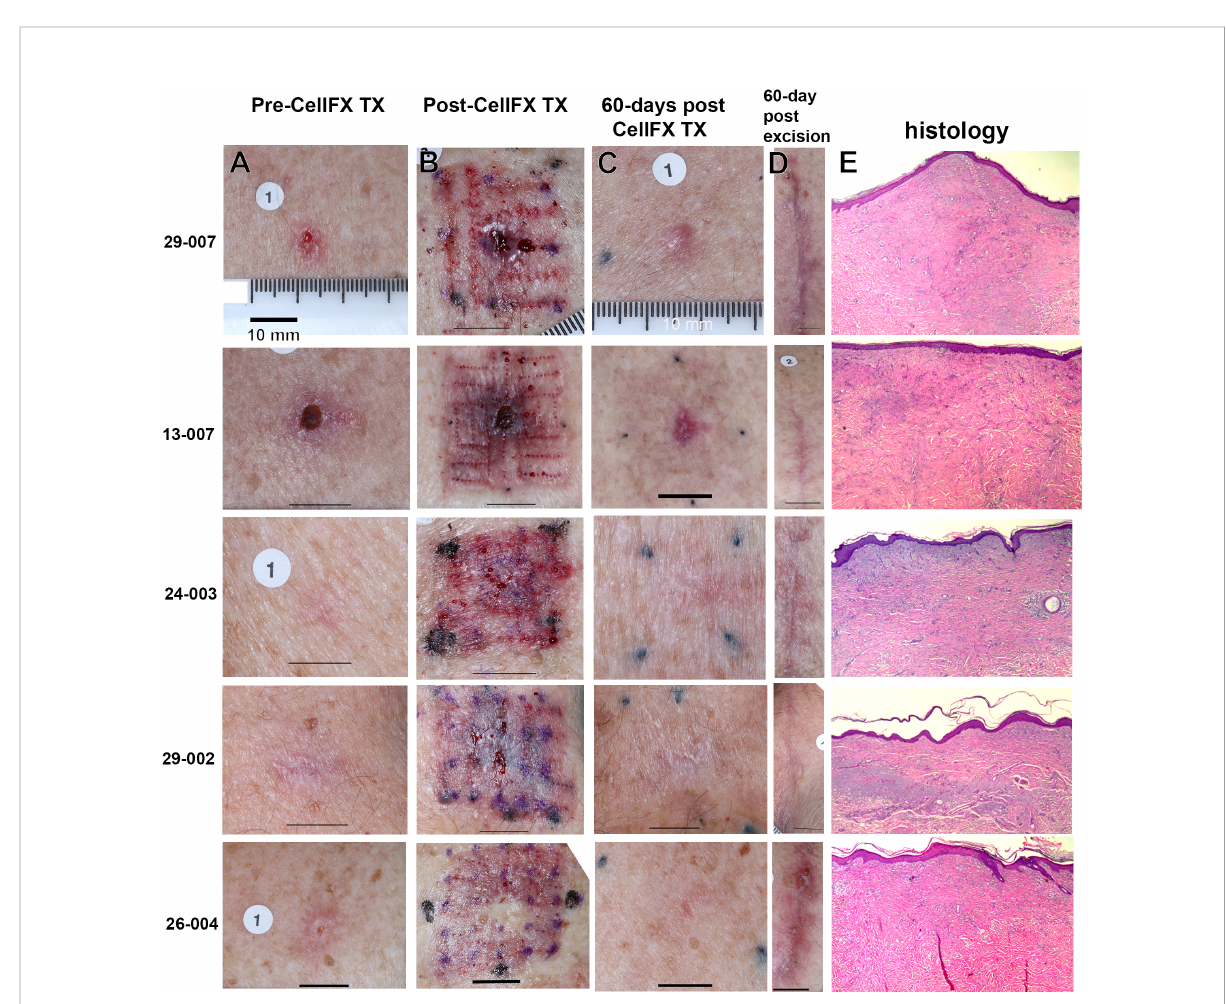
FIGURE 2 Five BCC lesions treated with the CellFX System and excised after 60 days for histological examination. 29-007 was treated with four placements of the 10 x 10 mm tip; 13-007 was treated with nine placements of the 7.5 x 7.5 mm tip; the remaining three were treated with 9, 12, and 16 placements, respectively, of the 5 x 5 mm tip. (A) Photos of lesions before treatment. (B) Photos of lesions immediately after treatment. (C) Photos of lesions 60 days after treatment. (D) The appearance of the skin 60 days post-excision is shown for comparison to the skin appearance 60 days post-CellFX. (E) Tissue sections (5-µm thick) stained with H&E all indicate clearance of the BCC. The scale bar in each image represents 10